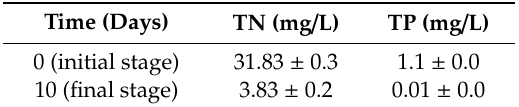
Table 1. The chemical composition of wastewater from